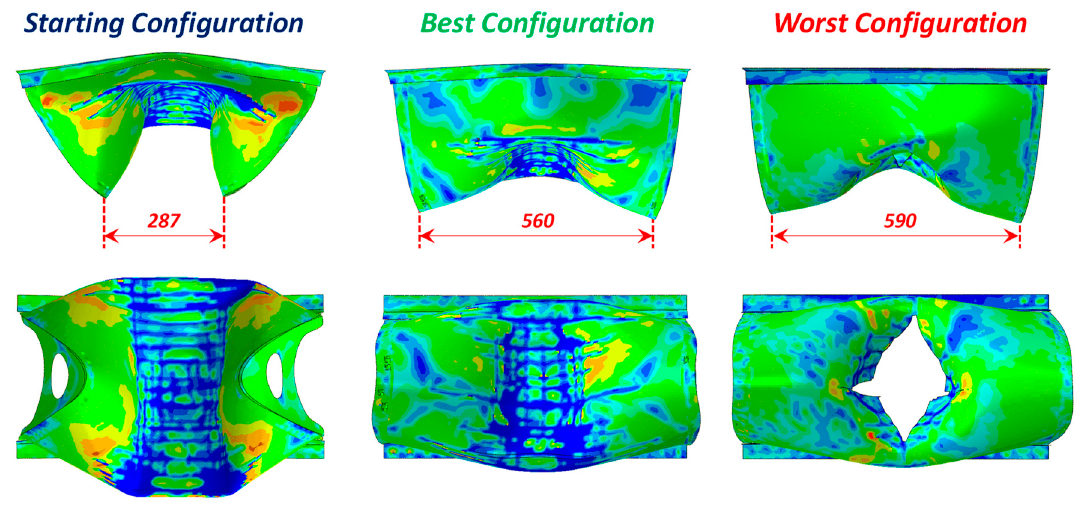
Figure 17. Deformed configurations.